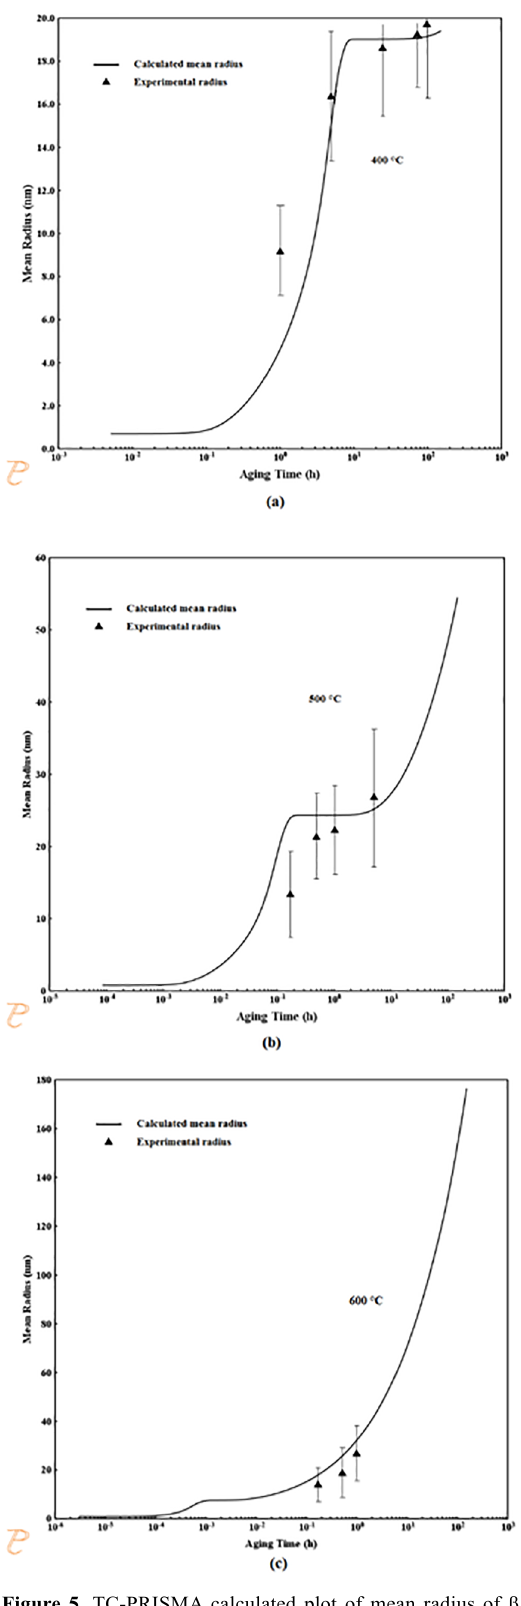
Figure 5. TC-PRISMA calculated plot of mean radius of β´ precipitate versus time for Cu-4wt. % Ti alloy aged at (a) 400 ºC, (b) 500 ºC and (c) 600